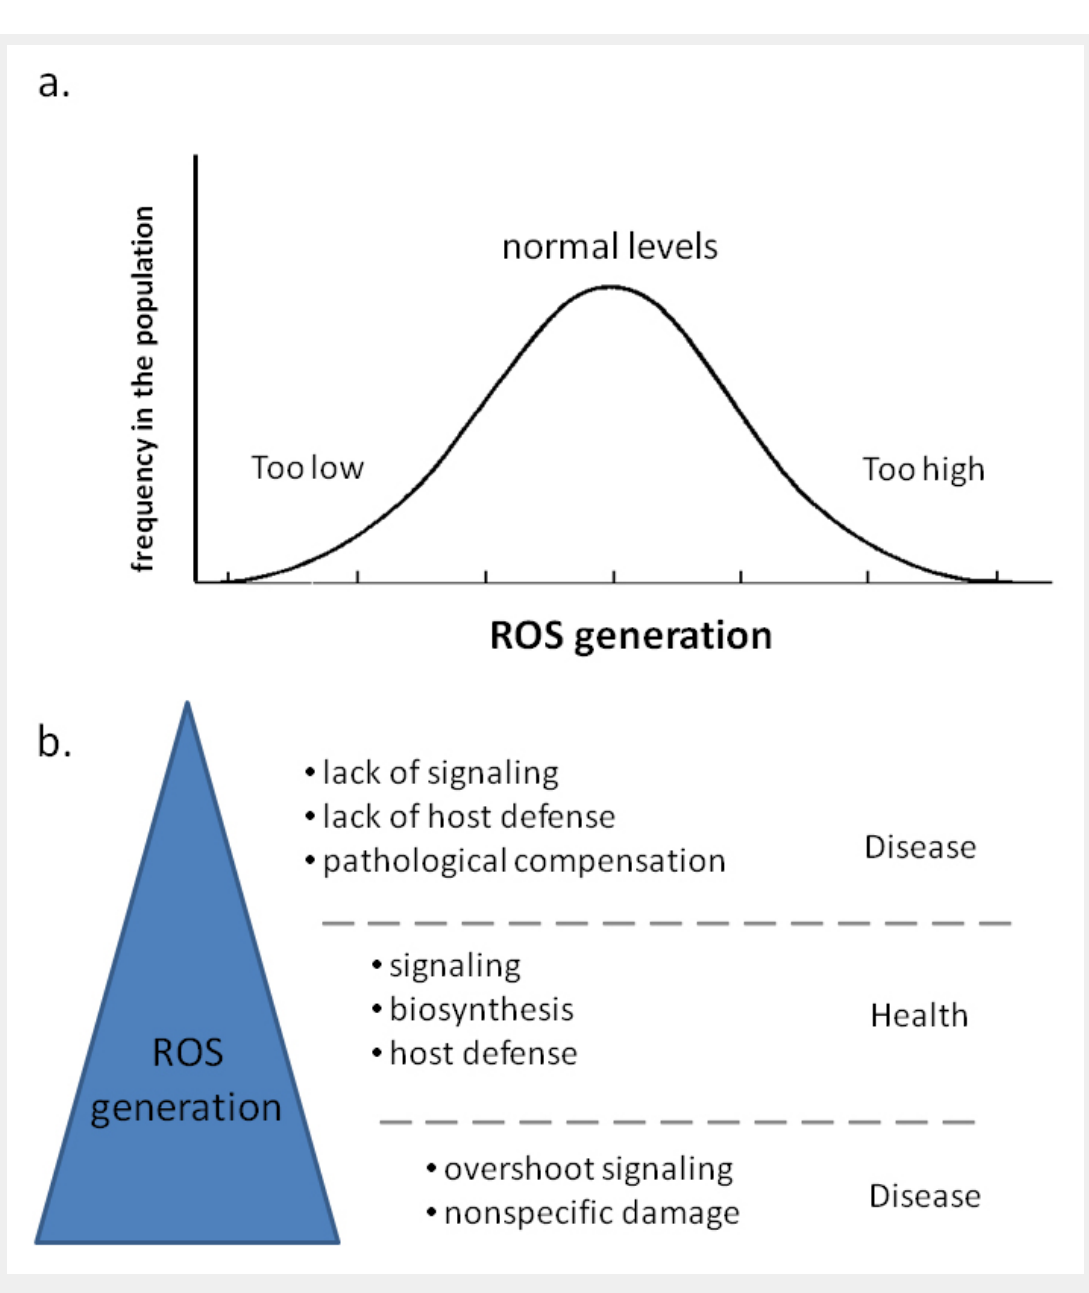
Variations of ROS generation. (a) Conceptual representation of genetically-determined ROS generation in the human population. Globally, there are significant variations of ROS generation. Note, however, that there is also regulation of ROS generation by epigenetics and external influences. (b) At moderate levels, NOX have crucial roles in health through mechanisms including signaling, biosynthetic processes, and host defence. When ROS levels are too low, the condition may result in decreased antimicrobial defence (e.g. chronic granulomatous disease), hypothyroidosis, low blood pressure or loss of otoconia. When levels are too high, there is increased cardiovascular disease, neurological disorders, cancers, and chronic